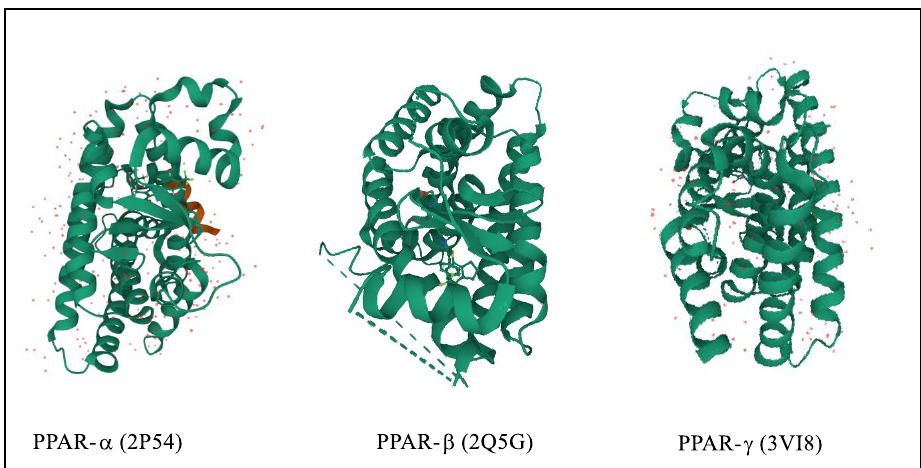
Figure 2. 3D structure of PPARα/β/γ .